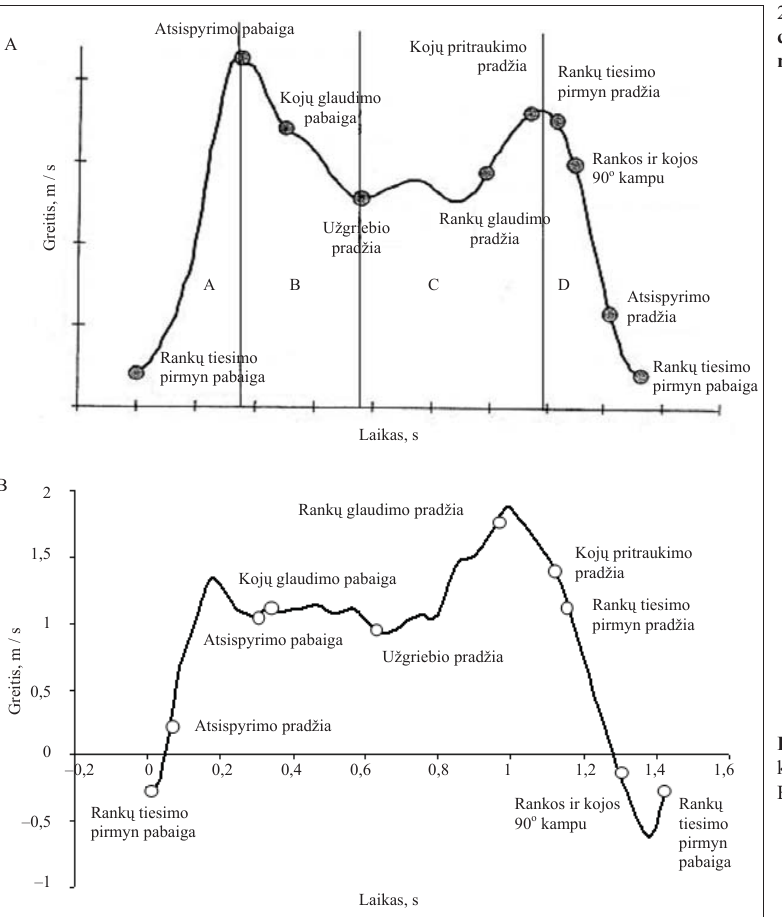
B — Lietuvos plaukik ų grei č io kreiv ė